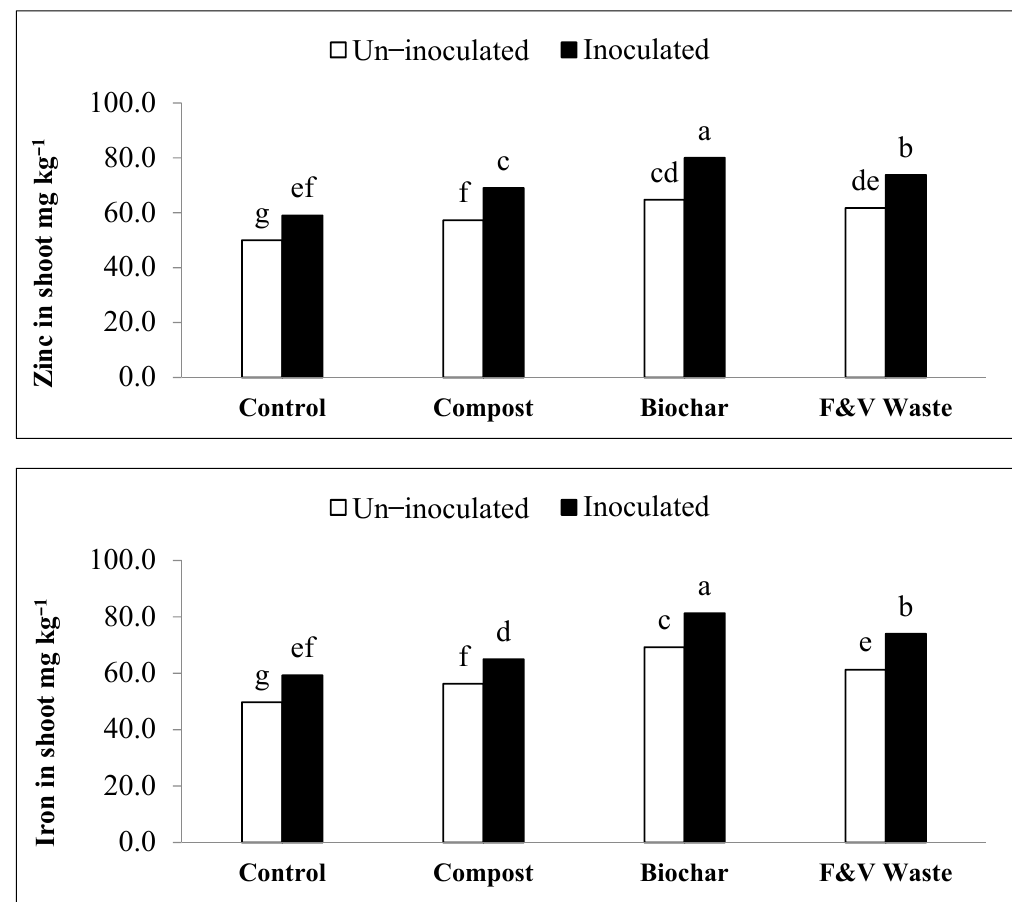
Figure 2. Effect of biochar, fruit and vegetable waste, compost and Bacillus subtilis SMBL 1 on Fe and Zn contents in okra with un-inoculated treatment set (Control = no bacterial inoculation) and inoculated treatment set (Control = SMBL 1). Different letters indicate significant differences according to least significant difference test at ( p ≤ 0.05) .